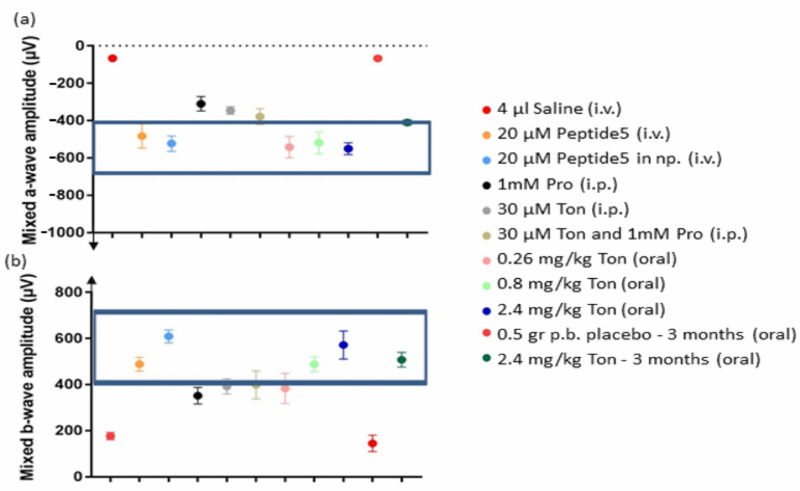
Figure 6. Overall analysis of the mixed a-wave amplitude which deflects downwards ( a ) and b-wave amplitude which deflects upwards ( b ) of the ERG for each of the connexin or pannexin blockers (or combination) applied to the light-damaged rat retina. The a-wave and b-wave amplitude in the ERGs improved towards the normal retinal function ranges for all the Cx43 hemichannel blocking treatments trialed compared to probenecid, which significantly ameliorated the response, but not to a normal level. Statistical analysis was conducted using one-way ANOVA, followed by a post- hoc test comparing computer-generated normal ERG values with treatment values. The normality values were randomly selected between − 400 to − 700 µ V for the a-wave, and between 400 to 700 µ V for the b-wave [46]. The boxed area shows treatments that preserved retinal function and were non-significantly different from normal values. Abbreviations: i.v., intravitreal; i.p. intraperitoneal; np, nanoparticles; Pro, probenecid; Ton, tonabersat; p.b. peanut